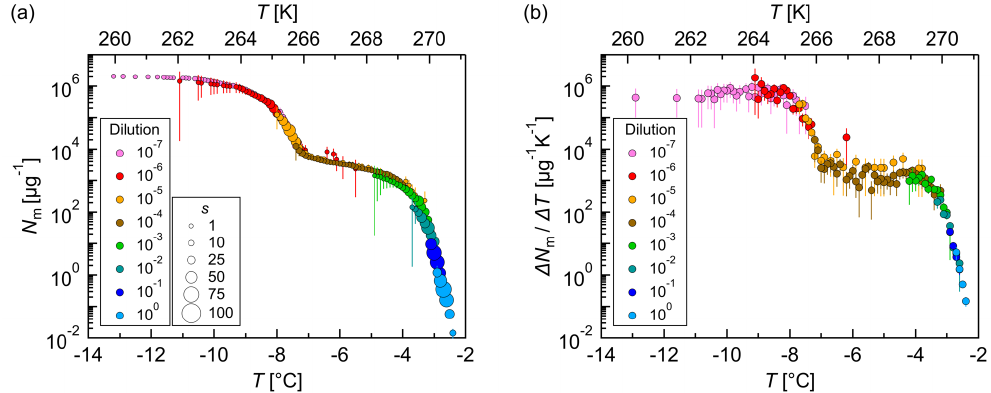
Figure 7. Measurements of dilution series of bacterial IN (Snomax ® ). (a) Cumulative number of IN ( N m ) and (b) differential number of IN ( (cid:49)N m /(cid:49)T ) per unit mass of Snomax ® vs. temperature ( T ). Droplets of the same dilution of three independent measurements were added to a total droplet number of 288 (3 × 96 droplets). Symbol colors indicate different dilutions; symbol size indicates the number of frozen droplets per 0.1K bin ( s ). The error bars were calculated using the counting error and the Gaussian error propagation. The temperature error is